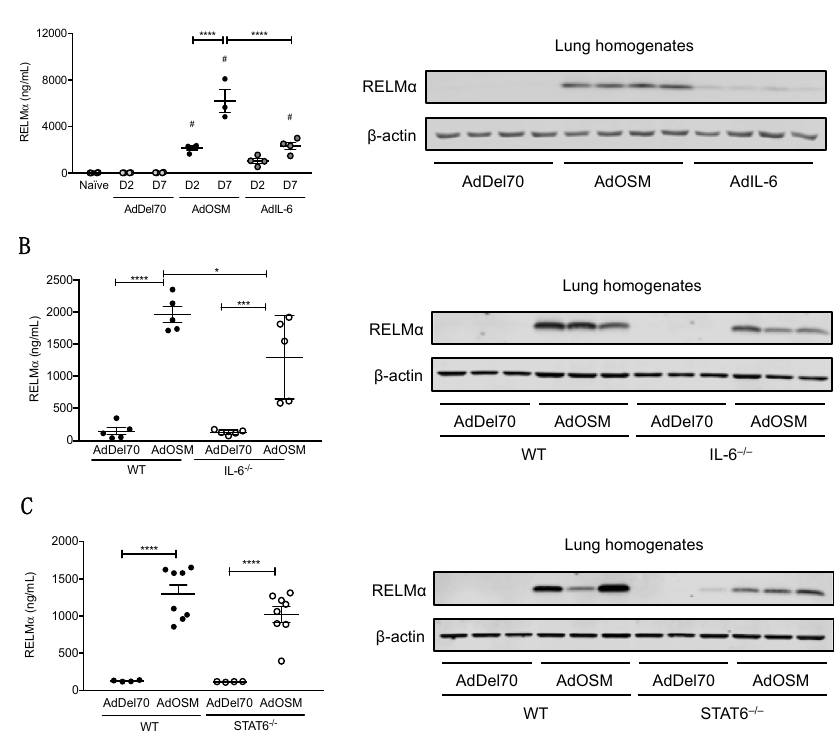
Figure 3. Induction of RELM α by OSM in whole lung IL-6 –/– and STAT6 –/– mice. ( A ) RELM α protein levels in BAL fluid from C57Bl/6 mice at day 2 or day 7 after AdDel70, AdOSM or AdIL-6 treatment, as assessed by ELISA (left panel). Total lung homogenates from separate C57Bl/6 mice 7 days post-infection were analyzed by Western blot for RELM α (right panel, 4 separate mice/group). ( B ) Total lung homogenates from wild-type and IL-6 –/– C57Bl/6 mice 7 days post-infection were analyzed by ELISA (left panel) and Western blot (3 separate mice/group, right panel) for RELM α protein levels. ( C ) Total lung homogenates from wild-type and STAT6 –/– C57Bl/6 mice 7 days post-infection were analyzed by ELISA (left panel) and Western blot (3 separate mice/group, right panel) for RELM α . Data for ELISAs (left panels) are expressed as mean ± SEM ( n = 4–8 mice/group). Statistical significance was determined by one-way or two-way ANOVA with Tukey’s post hoc test ( # p < 0.05 relative to controls at the indicated time point; ** p < 0.01, *** p < 0.001, **** p < 0.0001 between indicated groups).